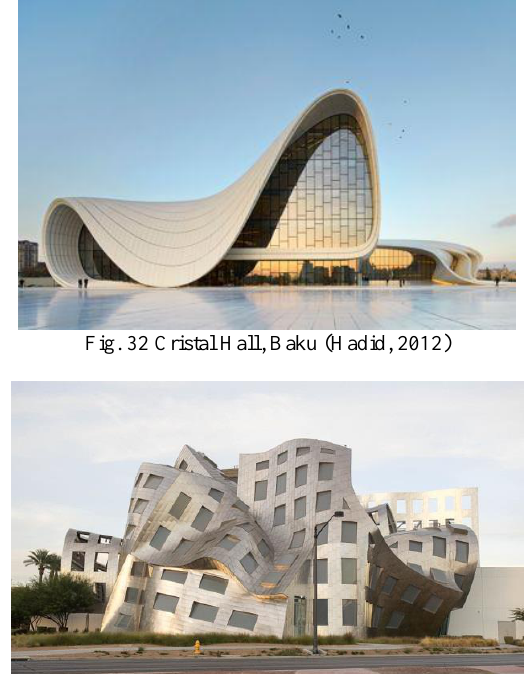
Fig. 33 Centre for brain health, Las Vegas ( Gehry, 2010)